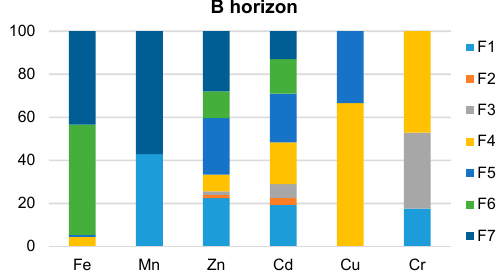
Figure 6. Sequential extraction of soil samples (%).